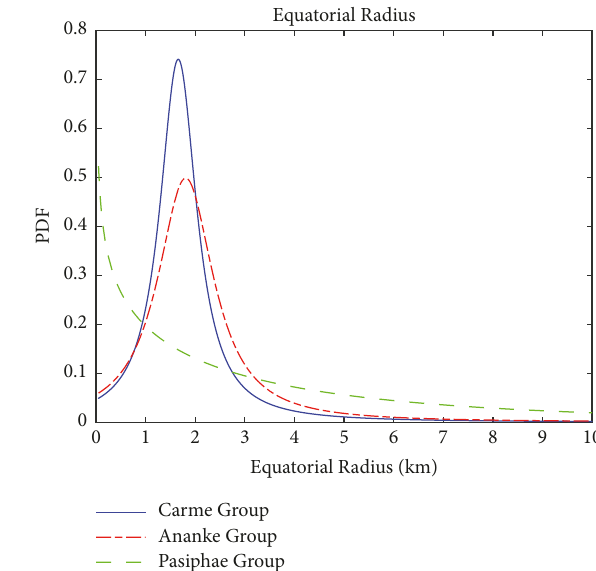
Figure 3: The PDF curves of orbit eccentricity.